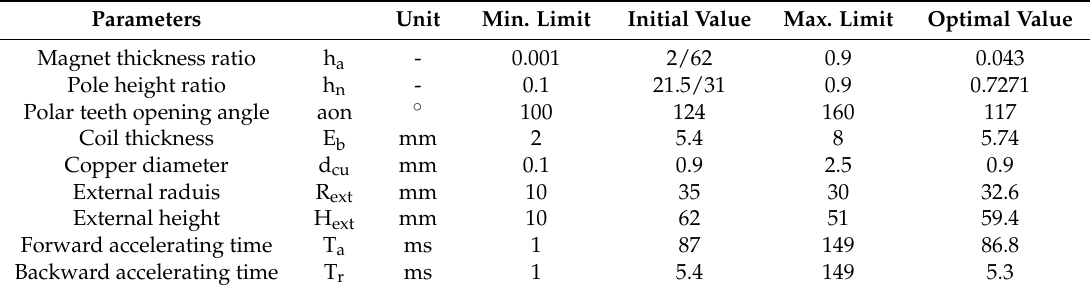
Table 1. Optimized parameter values.